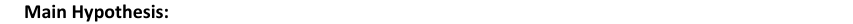
Table 1: Research Hypotheses